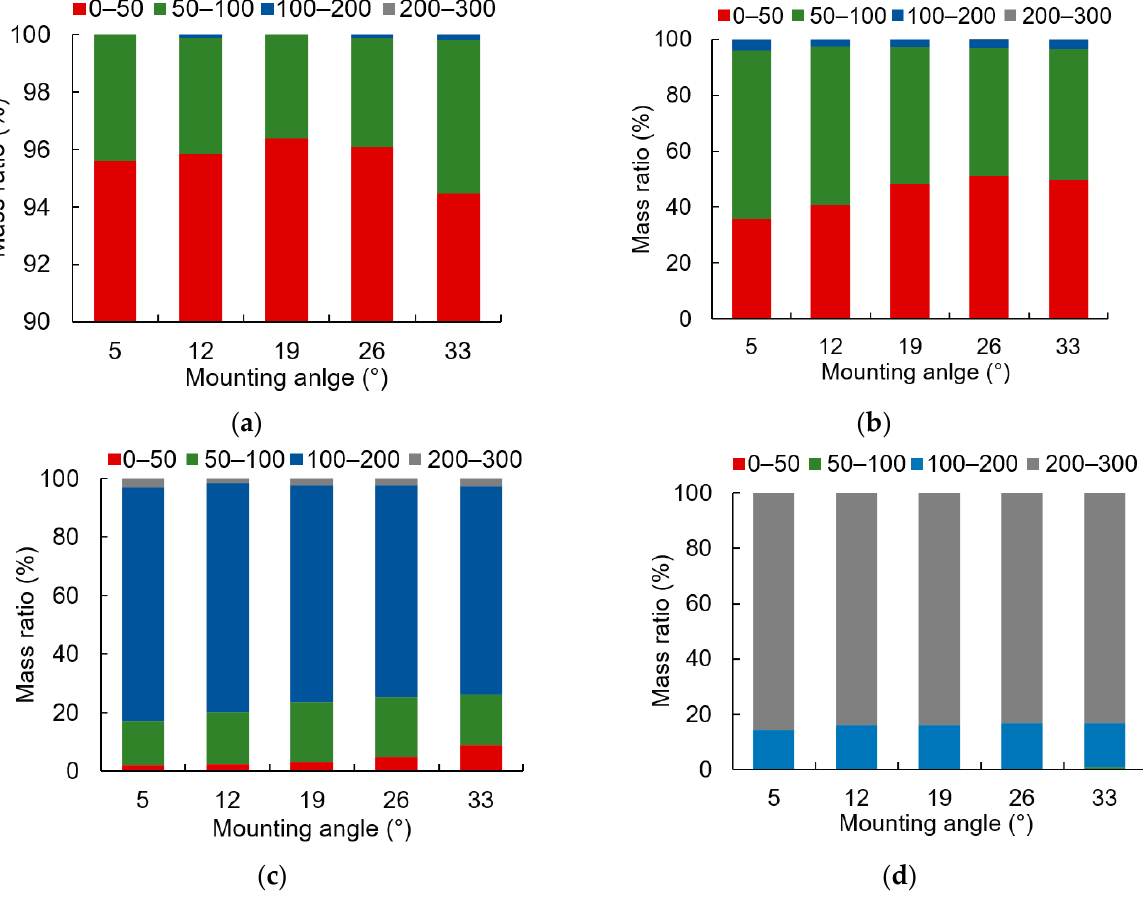
Figure 8. Mass ratio at various layers after subsoiling as affected by mounting angle: ( a ) Shallow seed layer; ( b ) Deep seed layer; ( c ) Middle layer; ( d ) Deep layer.